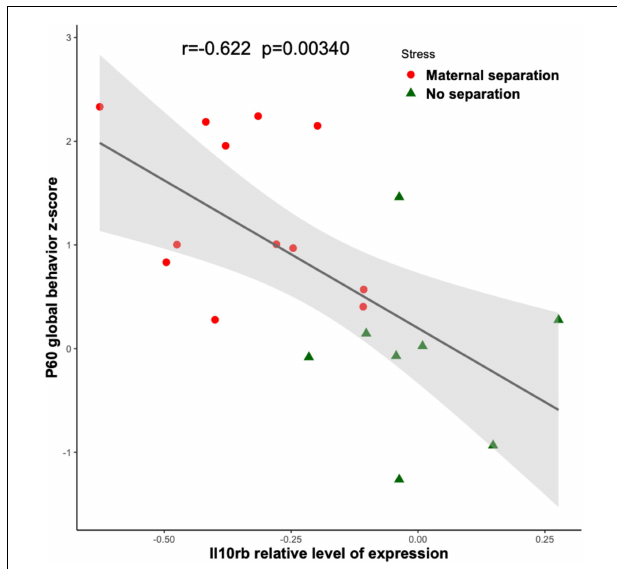
FIGURE 5 | Link between Il10rb relative level of transcriptional expression and depressive-like behavior. Linear regressions with 95% confidence intervals (in gray) are plotted between the depression-index and the Il10rb transcriptional relative level obtained by RT-qPCR from blood in MS (red circles) and NS (green triangles) adolescent mice. The Pearson correlation coefficient and the associated p -value are